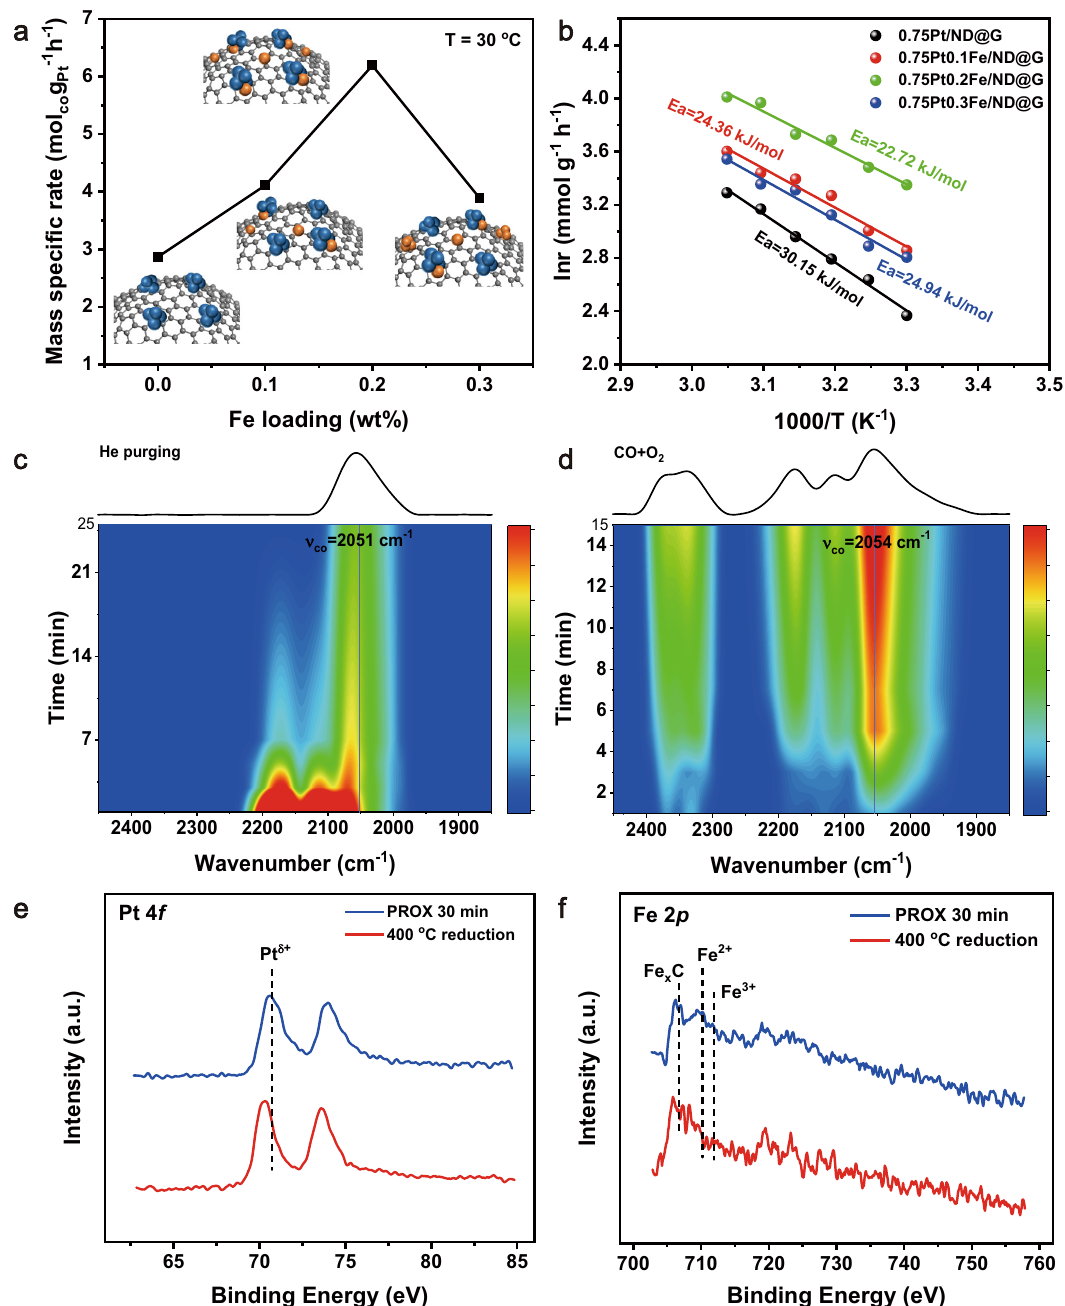
Fig. 4 | Catalytic mechanism of the 0.75Pt0.2Fe catalyst. a The correlation between Fe loading of PtFe/ND@G catalysts and catalytic performance for PROX reaction at 30°C . b Apparent activation energies of various PtFe/ND@G catalysts withdifferentFeloadinginPROXreaction. c InsituDRIFTSstudyofCOadsorption